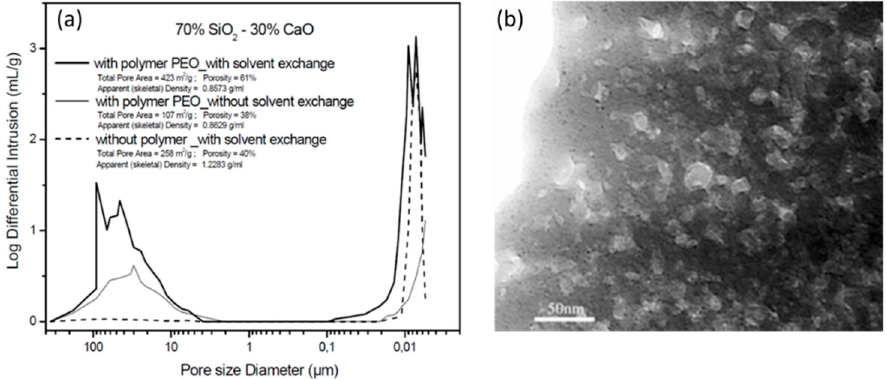
Figure 12. ( a ) Interconnected pore size distributions for SiO 2 -CaO heat treated monoliths, determined by Hg intrusion porosimetry. The samples analyzed were prepared both with and without PEO, as well as with and without solvent exchange. Reprinted by permission from Springer:Springer Nature, Journal of Materials Research, Sol-gel-derived glass scaffold with high pore interconnectivity and enhanced bioactivity, A.C. Marques, R.M. Almeida, A. Thiema, S. Wang,